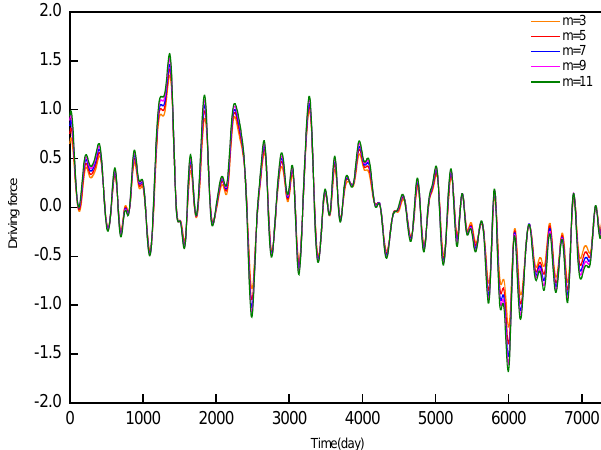
Figure 1. The true and constructed driving forces.